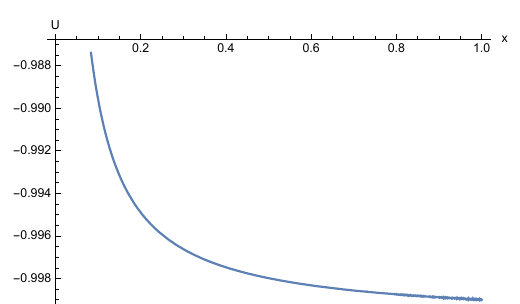
Figure 5. Plot of < U ( x ) > . Here, x = β / R 1 , R 0 = 1, G = m = M = 1. Note that the size of the container diminishes as x grows, so that the binding energy has to grow with x .